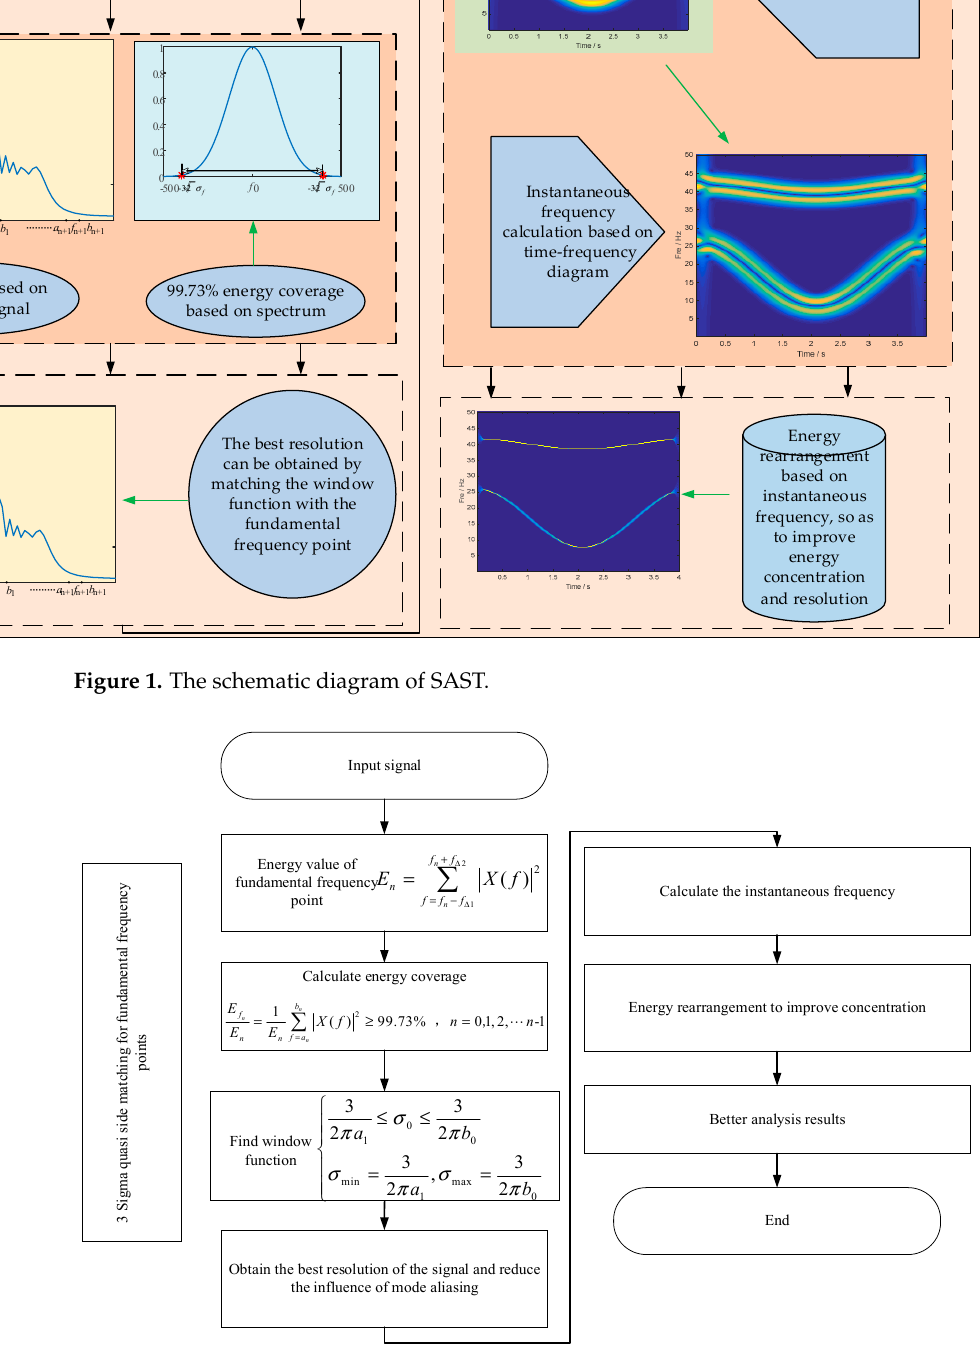
Figure 2. The flow chart of SAST.